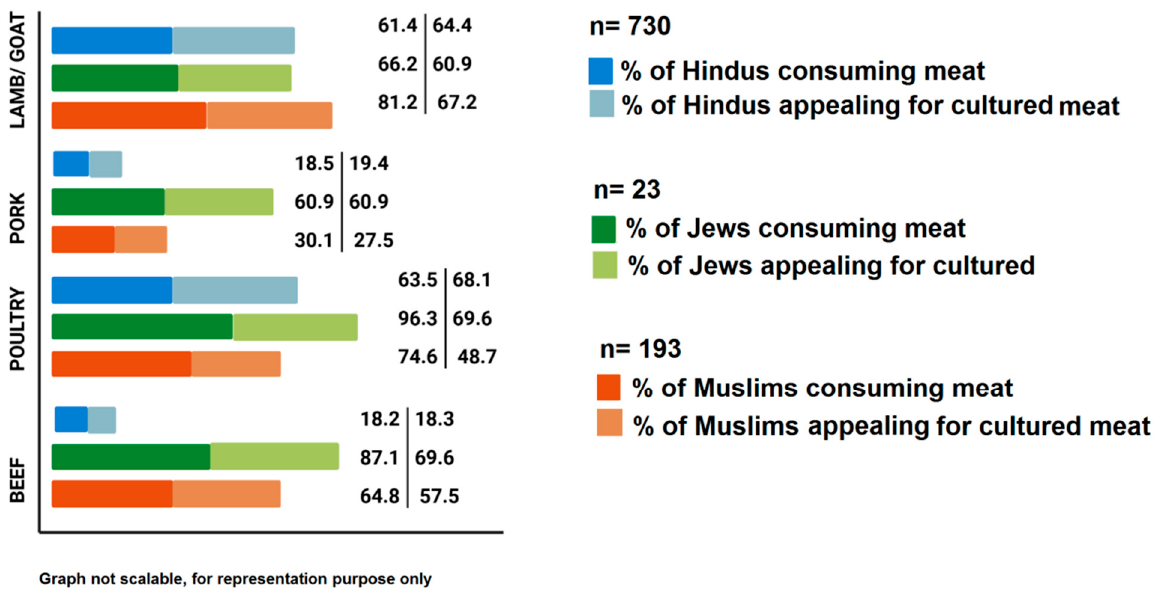
Figure 2. An illustration of the acceptance of in vitro meat across the three religions [18].